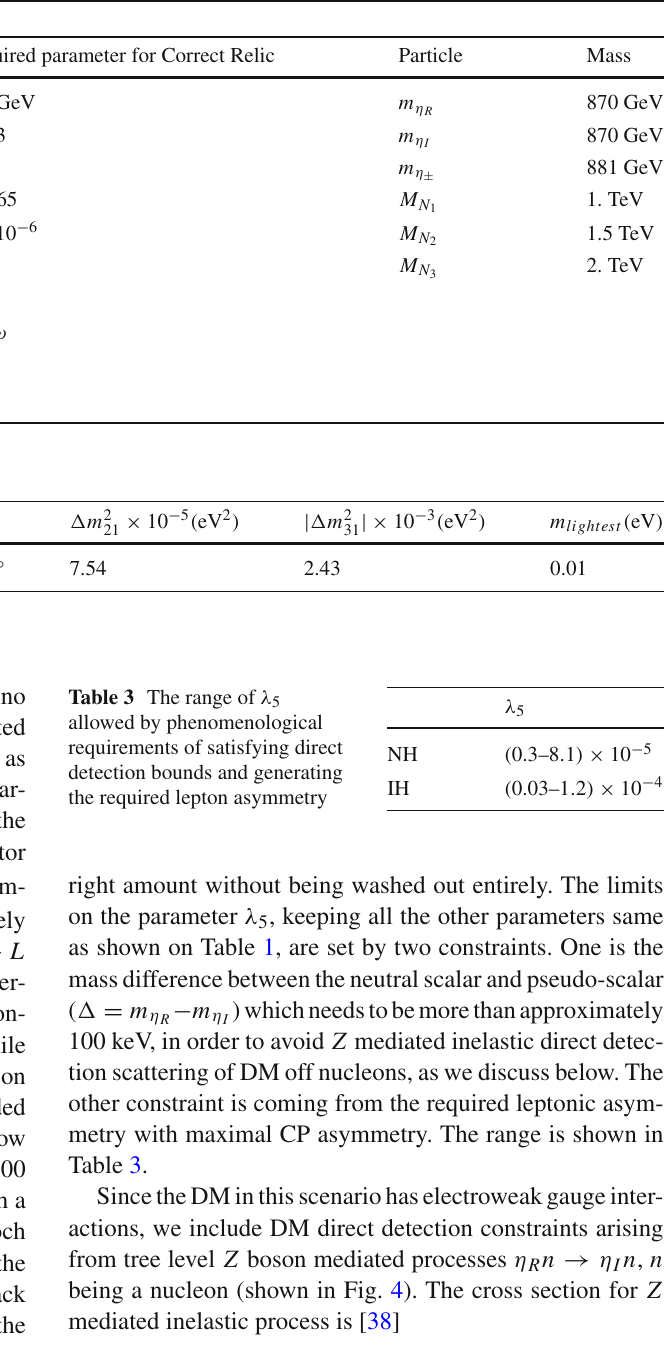
Parameter Required parameter for Correct Relic Particle